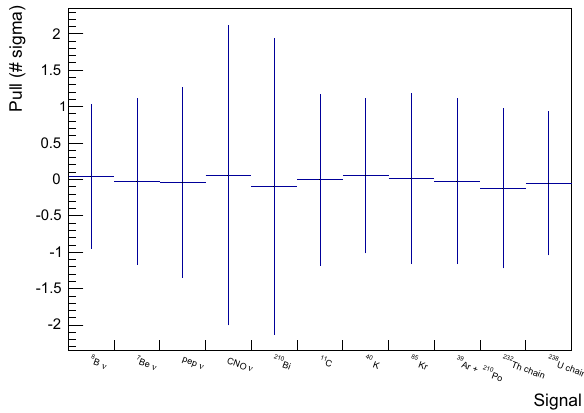
Fig. 8 Pulldistributionfor5yearsofdatawitha50kTpurescintillator detector and the baseline background assumptions. Note that the error bars show the RMS, and not the error on the mean. A mean pull of 0 with an RMS of 1 is expected for each signal in an unbiased fit